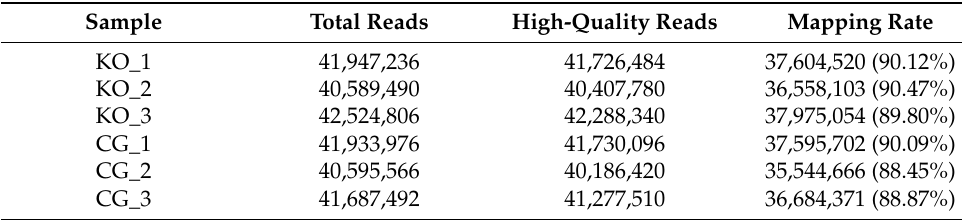
Table 4. Sequence results for MyoD1 gene knockouts.